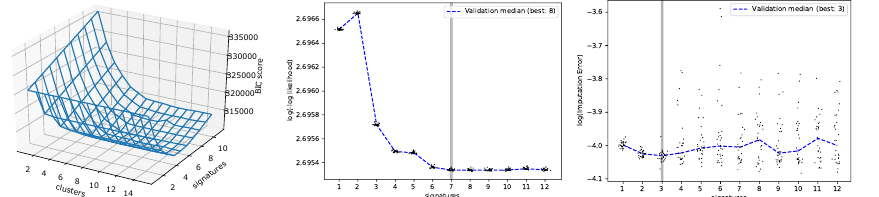
Figure 4. Performance evaluation on MSK-IMPACT data for varying number of signatures. Left : BIC scores of Mix with varying parameters. Middle : Btm2K log of minus log-likelihoods. Right : CV2K log reconstruction errors. For the middle and right panels, dots represent runs with their median denoted by a dashed line. The minimum median is denoted in the figure legend and the final chosen K is marked in gray.